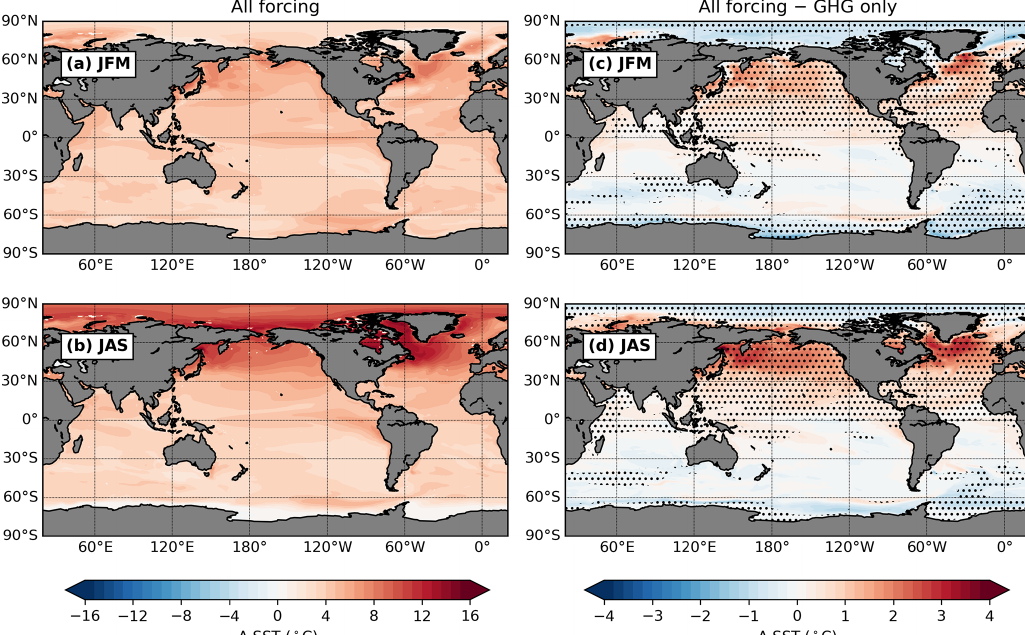
Figure 9. Panels (a) and (b) show the changes of the ensemble averaged SST ( ◦ C) between the period of 2070–2099 and 1985–2014 in (a) January, February, and March (JFM), and (b) July, August, and September (JAS) in the E3SMv1.0 all-forcing simulations. Panels (c) and (d) show the differences in the SST change between all-forcing simulations and GHG-only simulations. Dots in panels (c) and (d) highlight the regions where such differences are significant as compared to the variations among ensemble members. See the text for more details on how the significance is quantified.